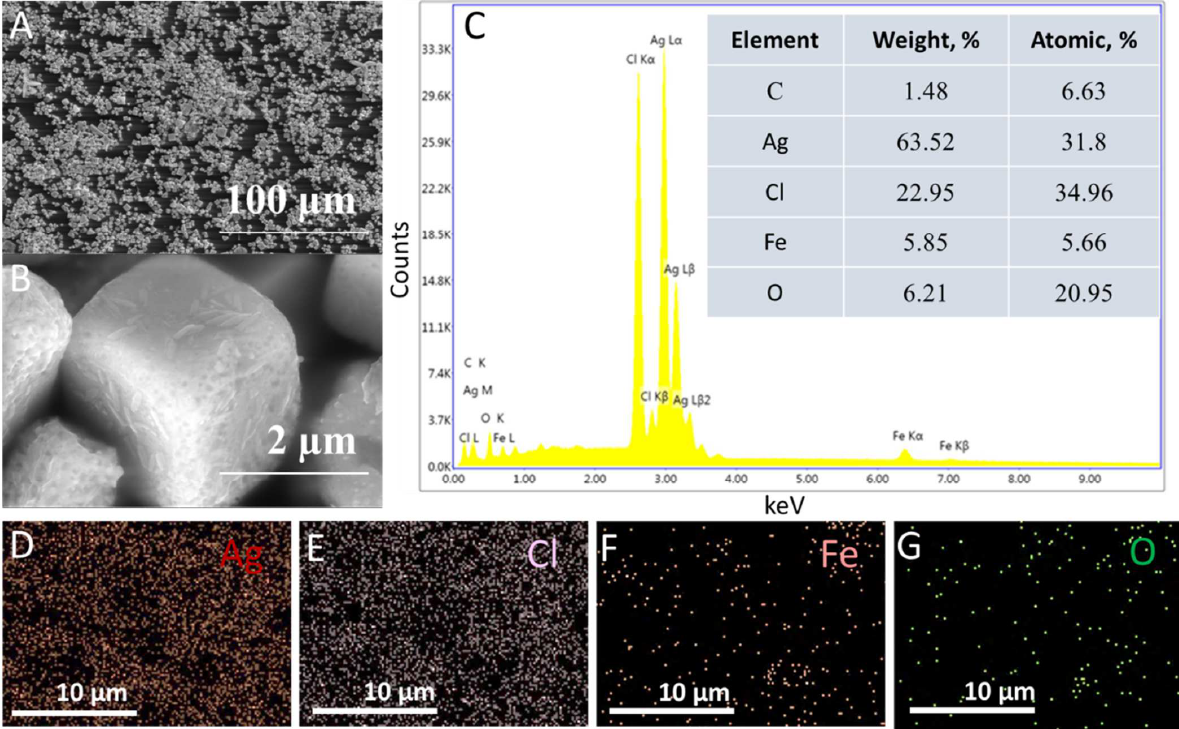
Figure 3. FESEM images low resolution ( A ) and high resolution ( B ) of EVA- Ag/AgCl/α-Fe 2 O 3 coating. A representative EDS spectrum and table with the atomic and weight percentage of elements ( C ), and elemental mapping of the elements Ag ( D ), Cl ( E ), Fe ( F ), and O ( G ). FESEM images of hematite nanowires can be found in the Supplementary Material (Figure S1).